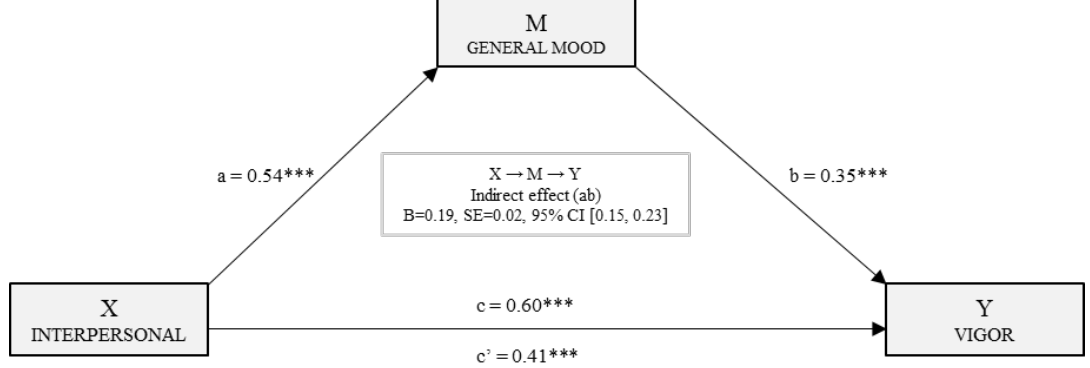
Figure 2. Simple mediation model of mood on the relationship between the interpersonal factor and the vigor dimension of engagement. (Note: *** p < 0.001)